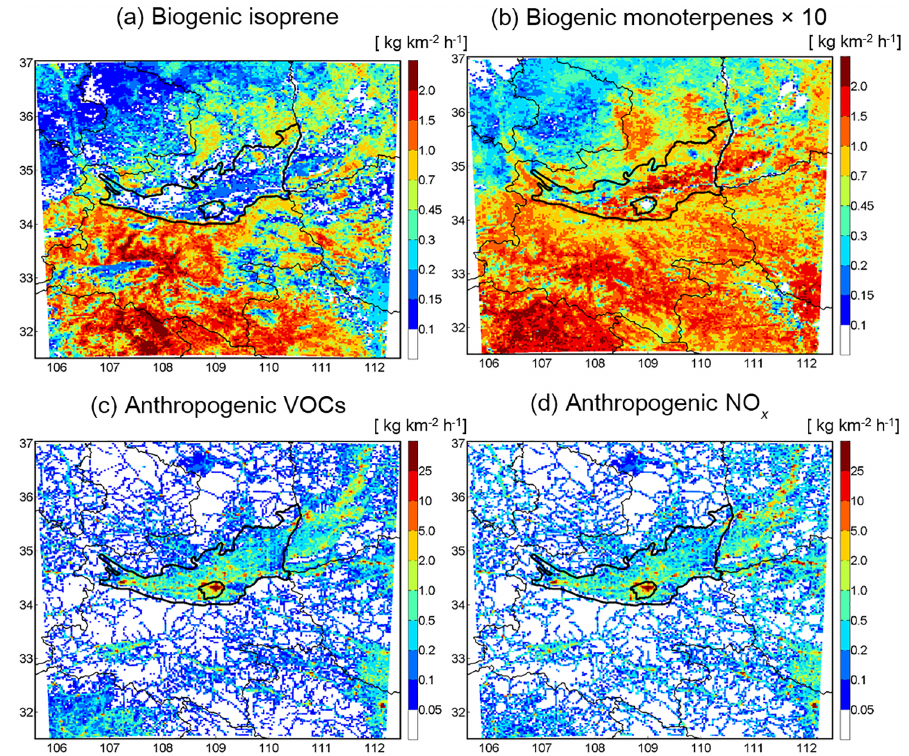
Figure 2. Monthly mean emissions of (a) biogenic isoprene, (b) biogenic monoterpenes, (c) anthropogenic VOCs, and (d) anthropogenic NO x in the GZ Basin and surrounding areas in August